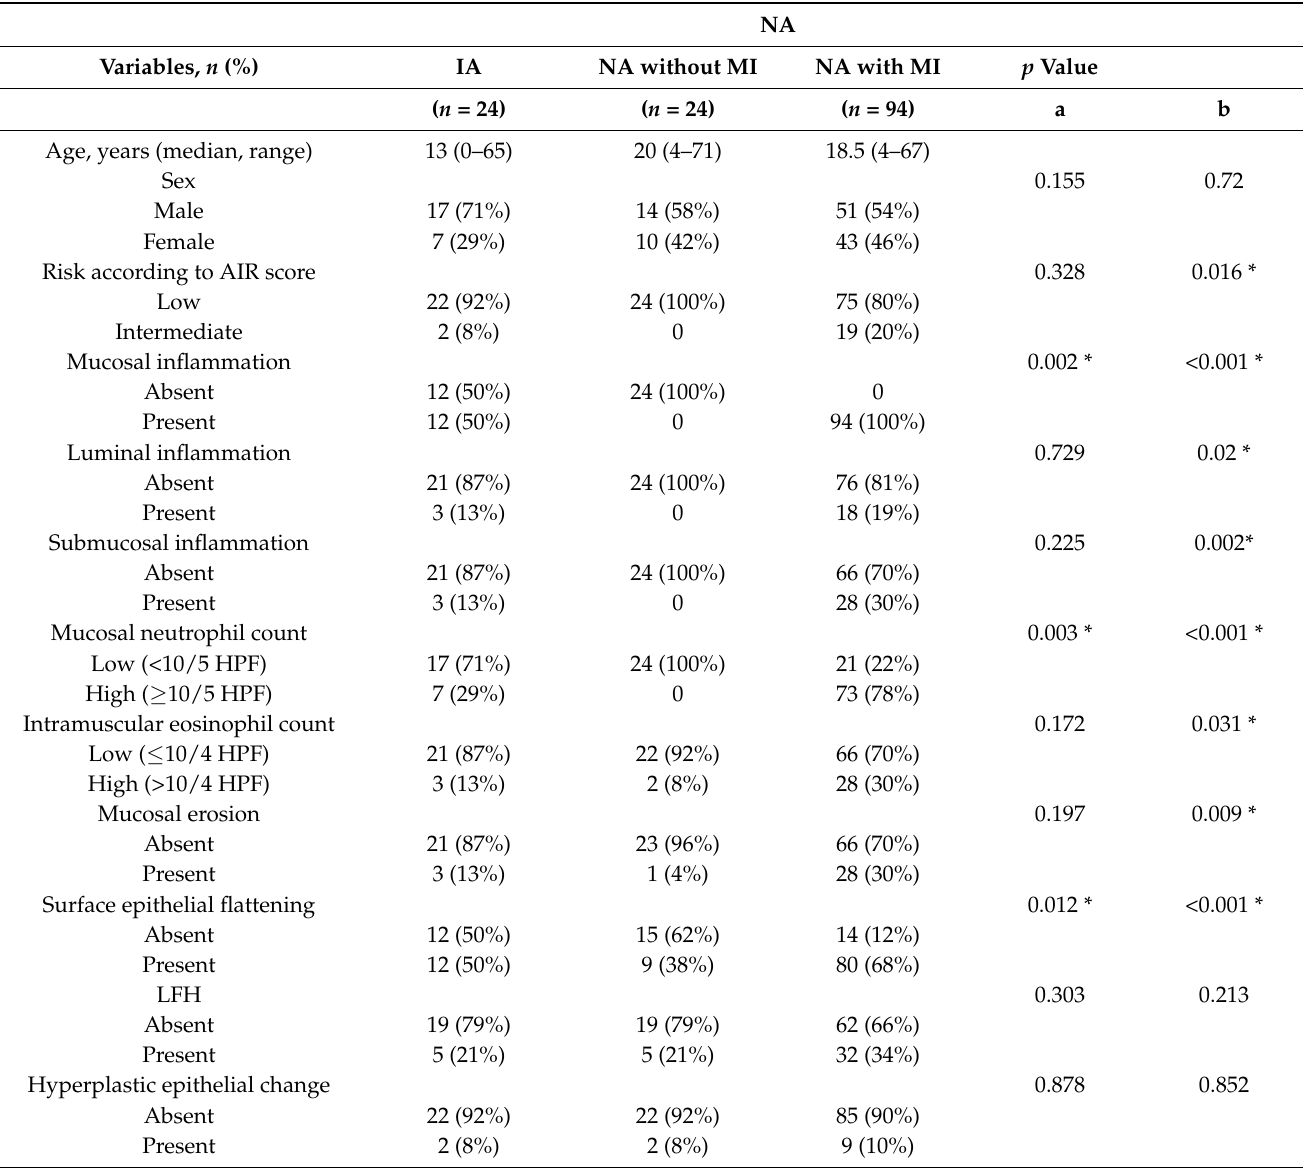
Table 1. Comparison of clinicopathologic features between negative appendectomy and incidental appendectomy